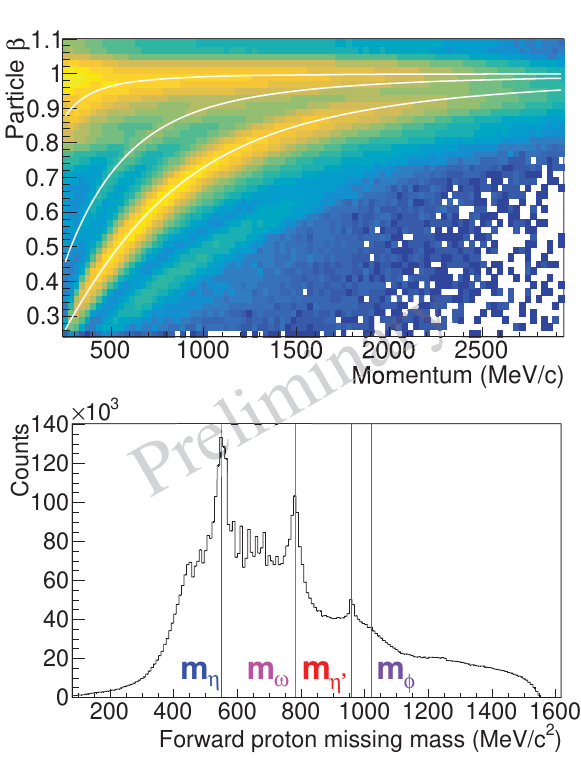
Figure 8. Top: Identification of γ n → K 0 with and without the Σ 0 → γ Λ decay additionally identified (red and blue lines respectively). Bottom: Energy of Σ 0 decay photon candidates in the Σ 0 rest frame for di ff erent scenarios labelled inset. Analysis by K. Kohl